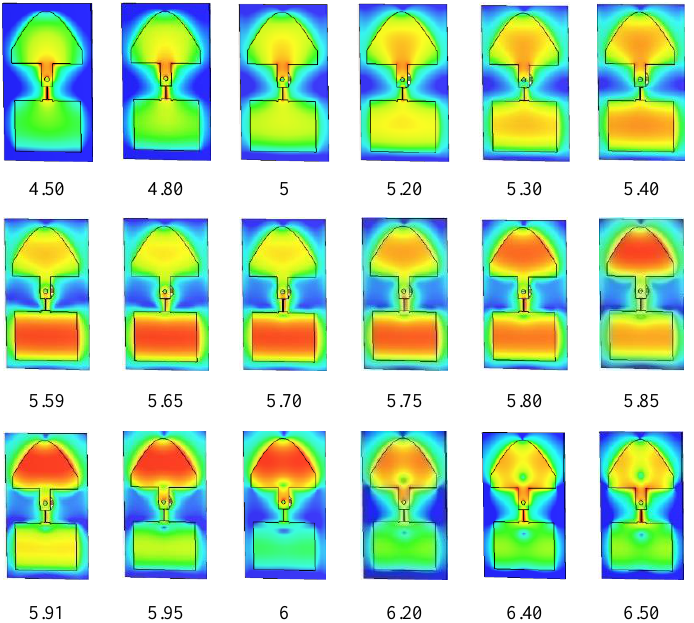
Figure 2. Current distributions on the proposed microstrip array as a function of frequency (in GHz).